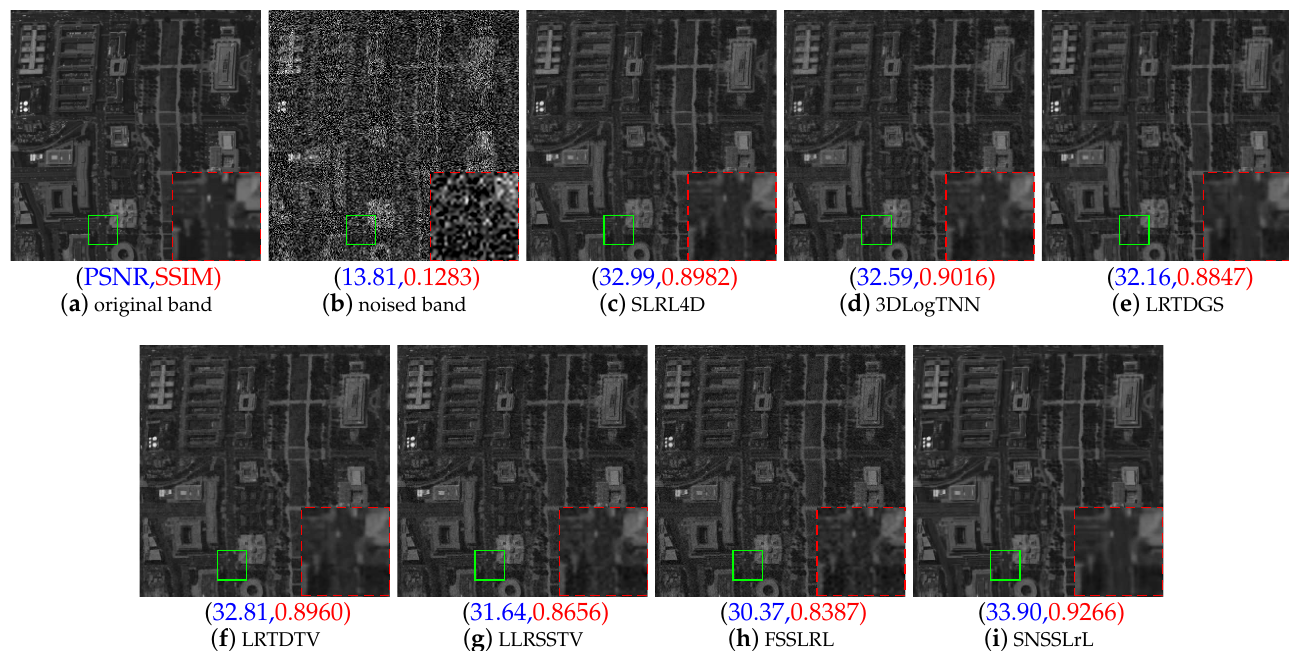
Figure 3. Band image on spectral band 28 of WDC dataset under simulated case 1. ( a ) Original band; ( b ) Noised band;